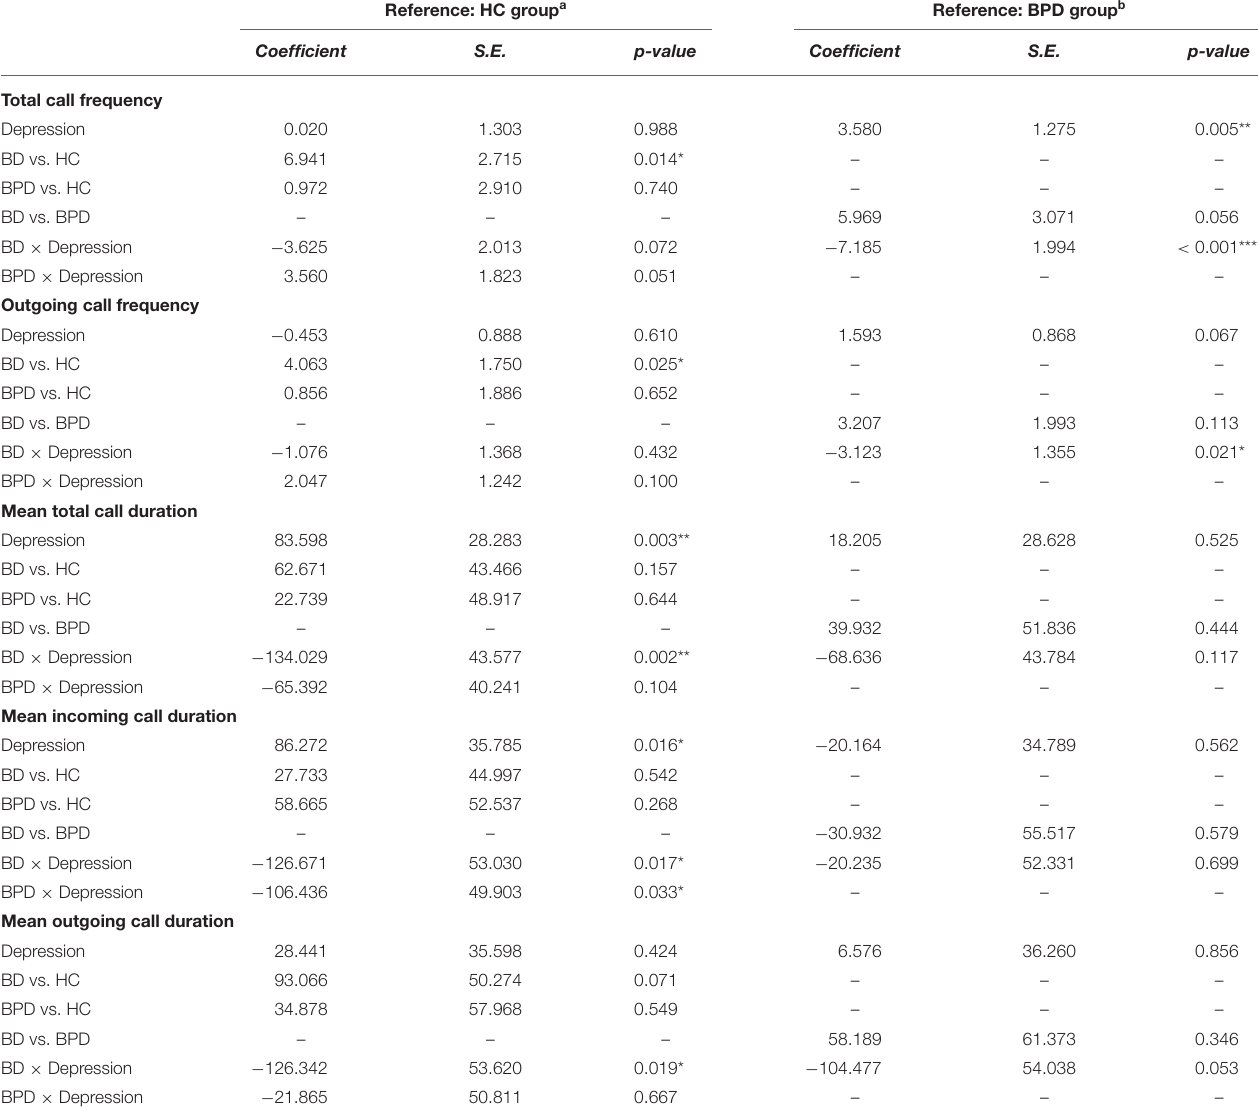
TABLE 6 | Phone call data by diagnosis & mood state interaction